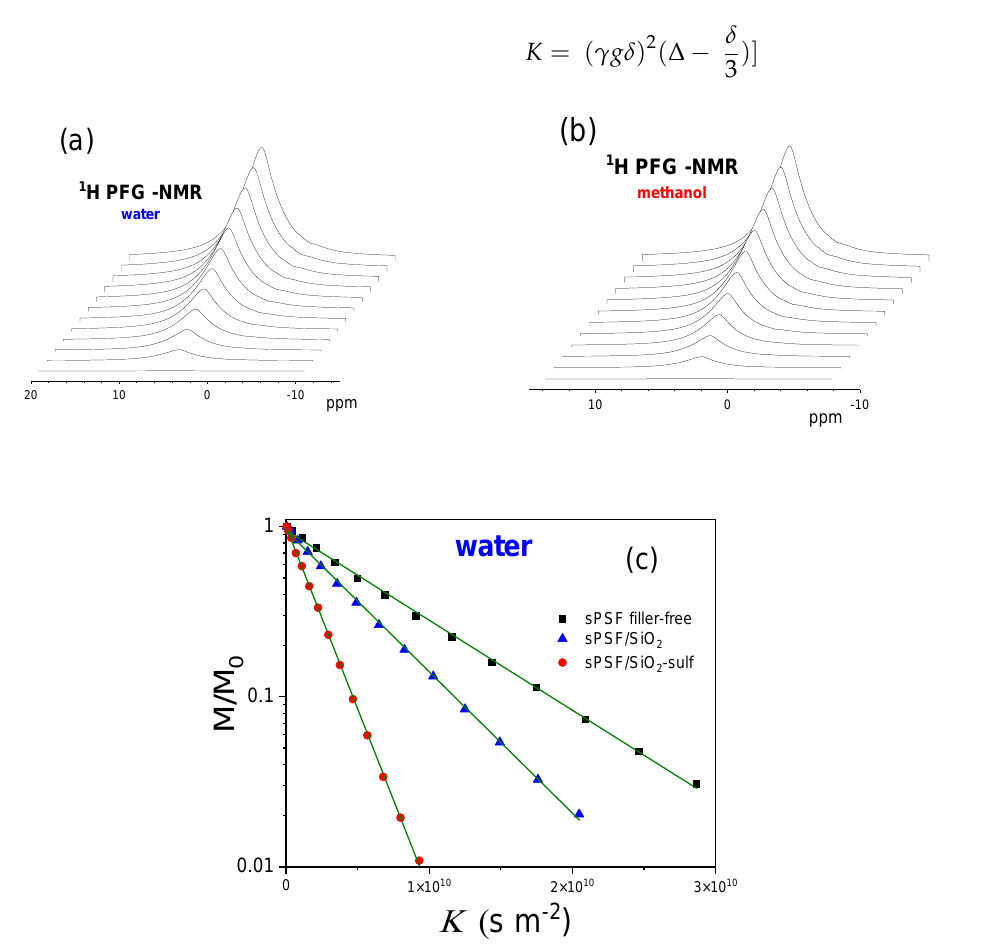
Figure 1. 1 H PFG NMR spectra corresponding to ( a ) water and ( b ) methanol absorbed in the Pebax membrane at 20 ◦ C. ( c ) Plot of the normalized peak areas vs. K (( γ g δ ) 2 ( ∆ − δ /3)) for water confined in the three membranes. The solid green line represents the linear fitting to the experimental data.